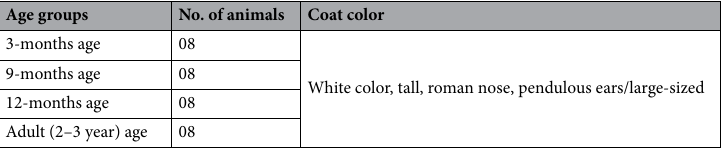
Table 9. Age of Jamunapari goats along with number of animals and coat